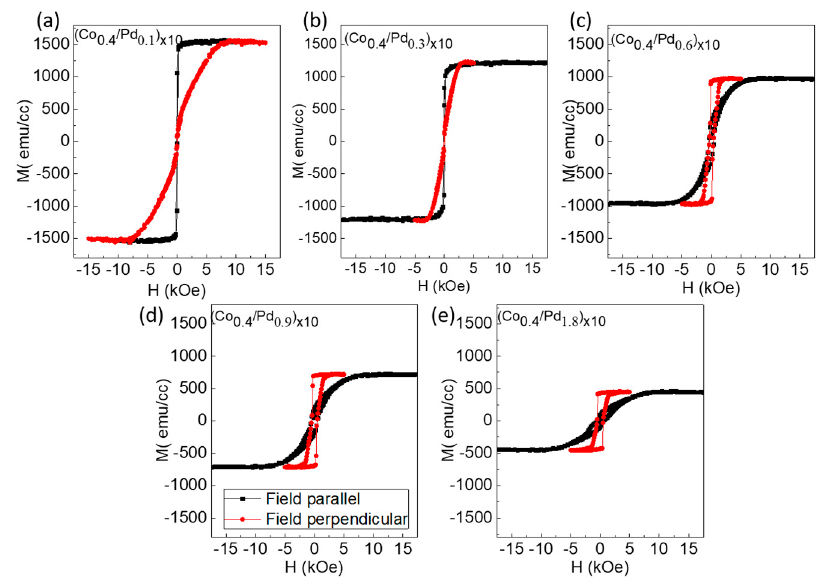
Figure 7. In-plane (black square) and out-of-plane (red circle) magnetic hysteresis loops of sample ( a ) (Co 0.4 /Pd 0.1 ) × 10 , ( b ) (Co 0.4 /Pd 0.3 ) × 10 , ( c ) (Co 0.4 /Pd 0.6 ) × 10 , ( d ) (Co 0.4 /Pd 0.9 ) × 10 , ( e ) (Co 0.4 /Pd 1.8 ) × 10 of series 4 with (Co 0.4 /Pd t Pd) ×10 . Table 2. Magnetization values of series 3 [(Co 0.2 /Pd t corresponding to different values of t Pd .